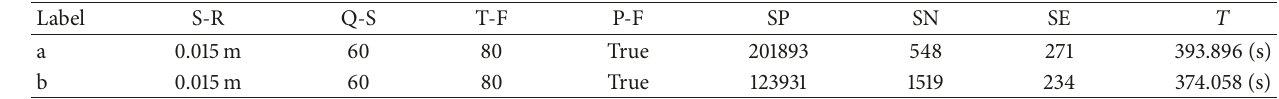
Table 1: Parameters and results of the proposed method and the shortest path method.